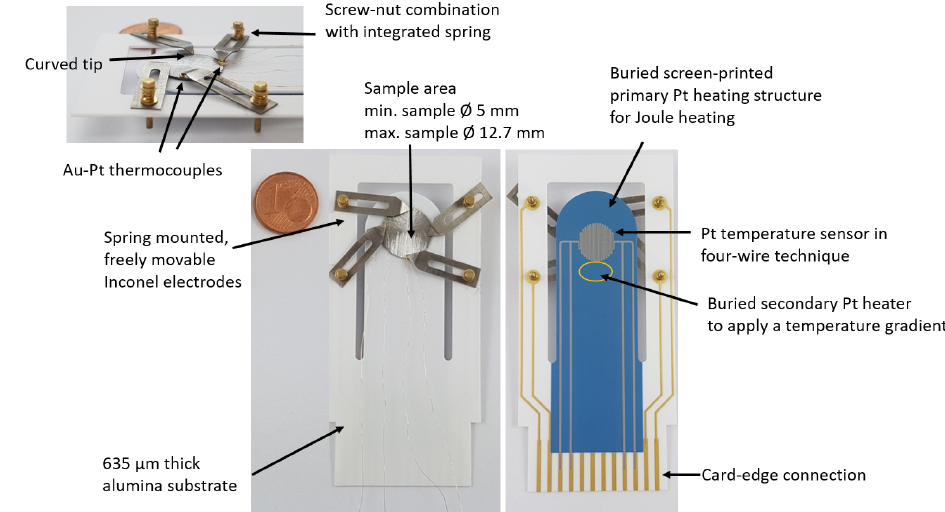
Figure 8. New sample holder generation with screen-printed primary and secondary heater, additional Pt temperature sensor, four freely movable, spring mounted electrodes, and two Au–Pt